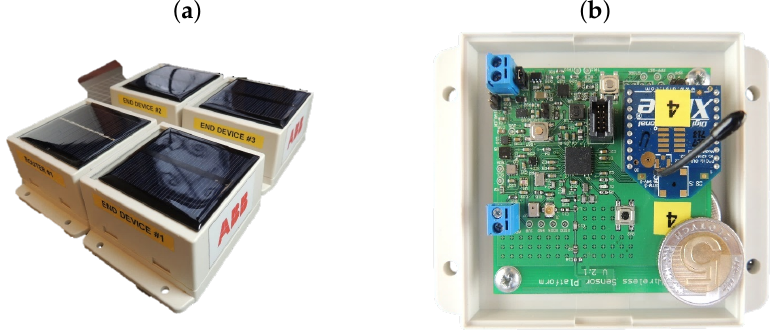
Figure 2. Picture of executive system devices—WSM, where ( a ) view with cover, ( b ) electronics’